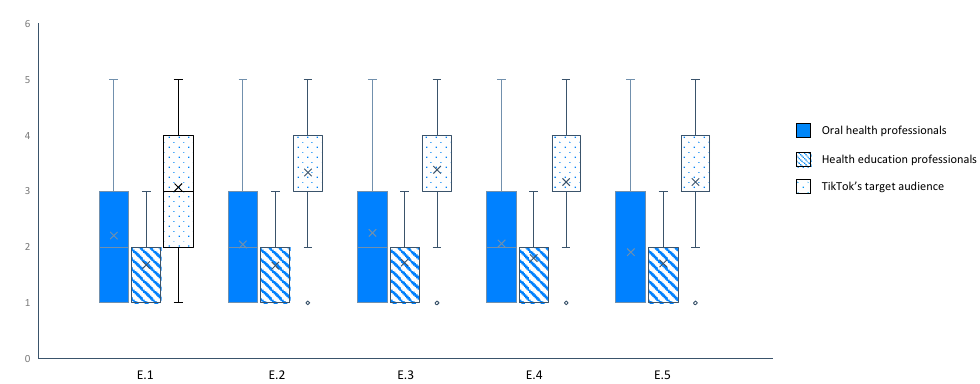
Figure 3. Subjective evaluation of TikTok videos corresponding to #oralhealtheducation. The Boxplot representing the quotation for question E.1 to E.5. E.1: Do you think the video is attractive?; E.2: Do you think the video is likely to increase awareness of the importance of oral health?; E.3: Do you think that video is likely to provide relevant information related to oral health?; E.4: Do you think the video is likely to change oral hygiene habits?; E.5: Overall score for the video.